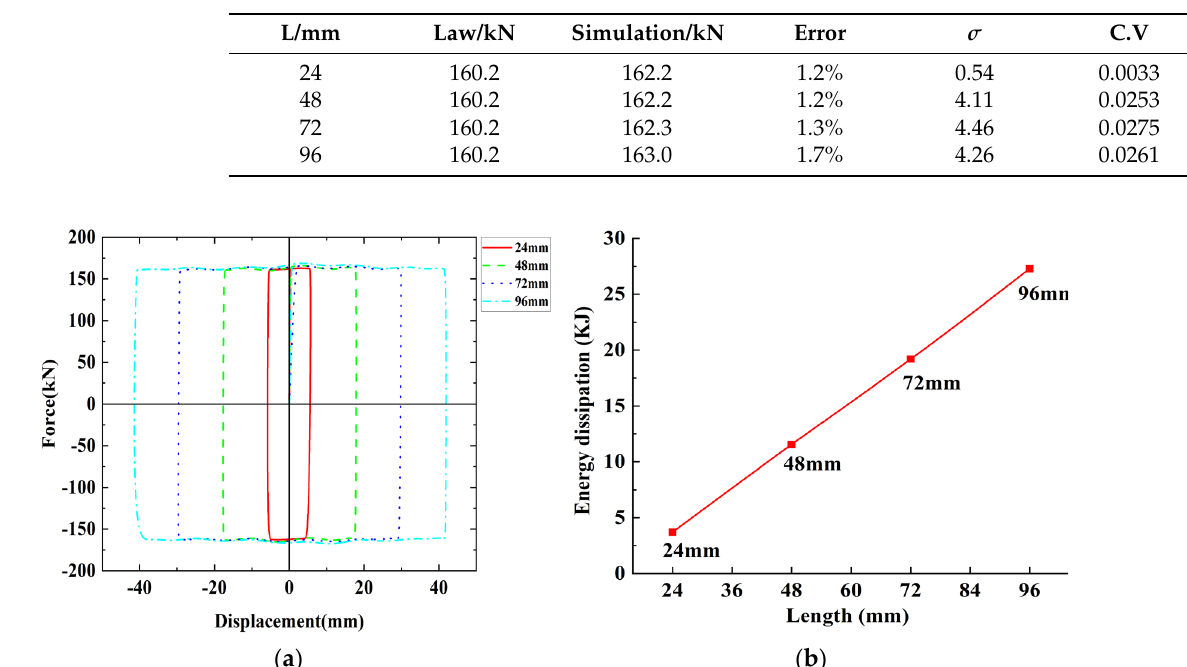
Figure 16. The comparison of hysteresis curves and energy dissipation of the finite element simulation with different slotted bolt holes length: ( a ) The comparison of hysteresis curves; ( b ) The comparison of energy dissipation.